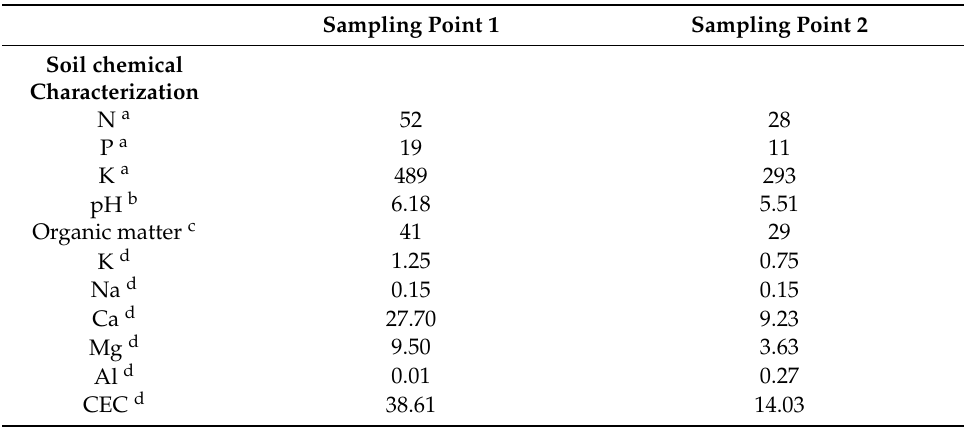
Figure 1. ( a ) Arachnitis uniflora growing in the understorey of a mixed forest in Cholchol. ( b ) Dust-like seeds of A. uniflora (scale bar = 1 mm). ( c ) Fungal hyphae (white arrow) growing outside the root (scale bar = 100 µ m). ( d ) Intracellular hyphal coils (white arrow) inside the root cortex (scale bar = 50 µ m). ( e ) Extracellular hyphal coils (white arrow) colonizing the root cortex (scale bar = 50 µ m). Table 1. Soil chemical characterization, plant species, and fungal sporocarps in the two microhabitats with Arachnitis uniflora plants.